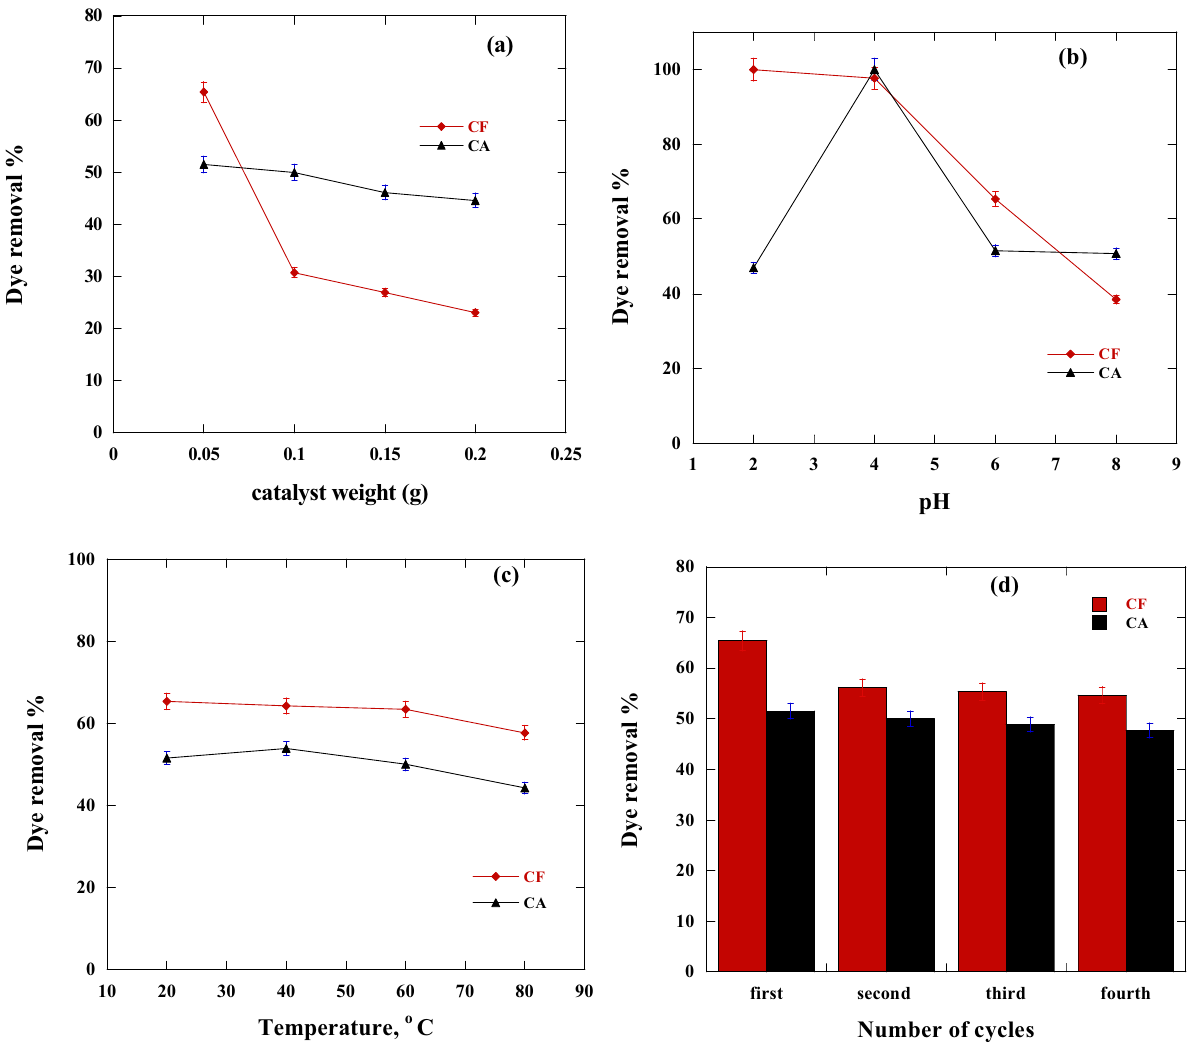
Figure 8. Effect of adsorption conditions on the removal % of DR dye by CA and CF where ( a ) represent the effect of adsorbent weight, ( b ) represent the effect of Initial pH of the solution, ( c ) represent the effect of adsorption temperature and ( d ) represent the reusability